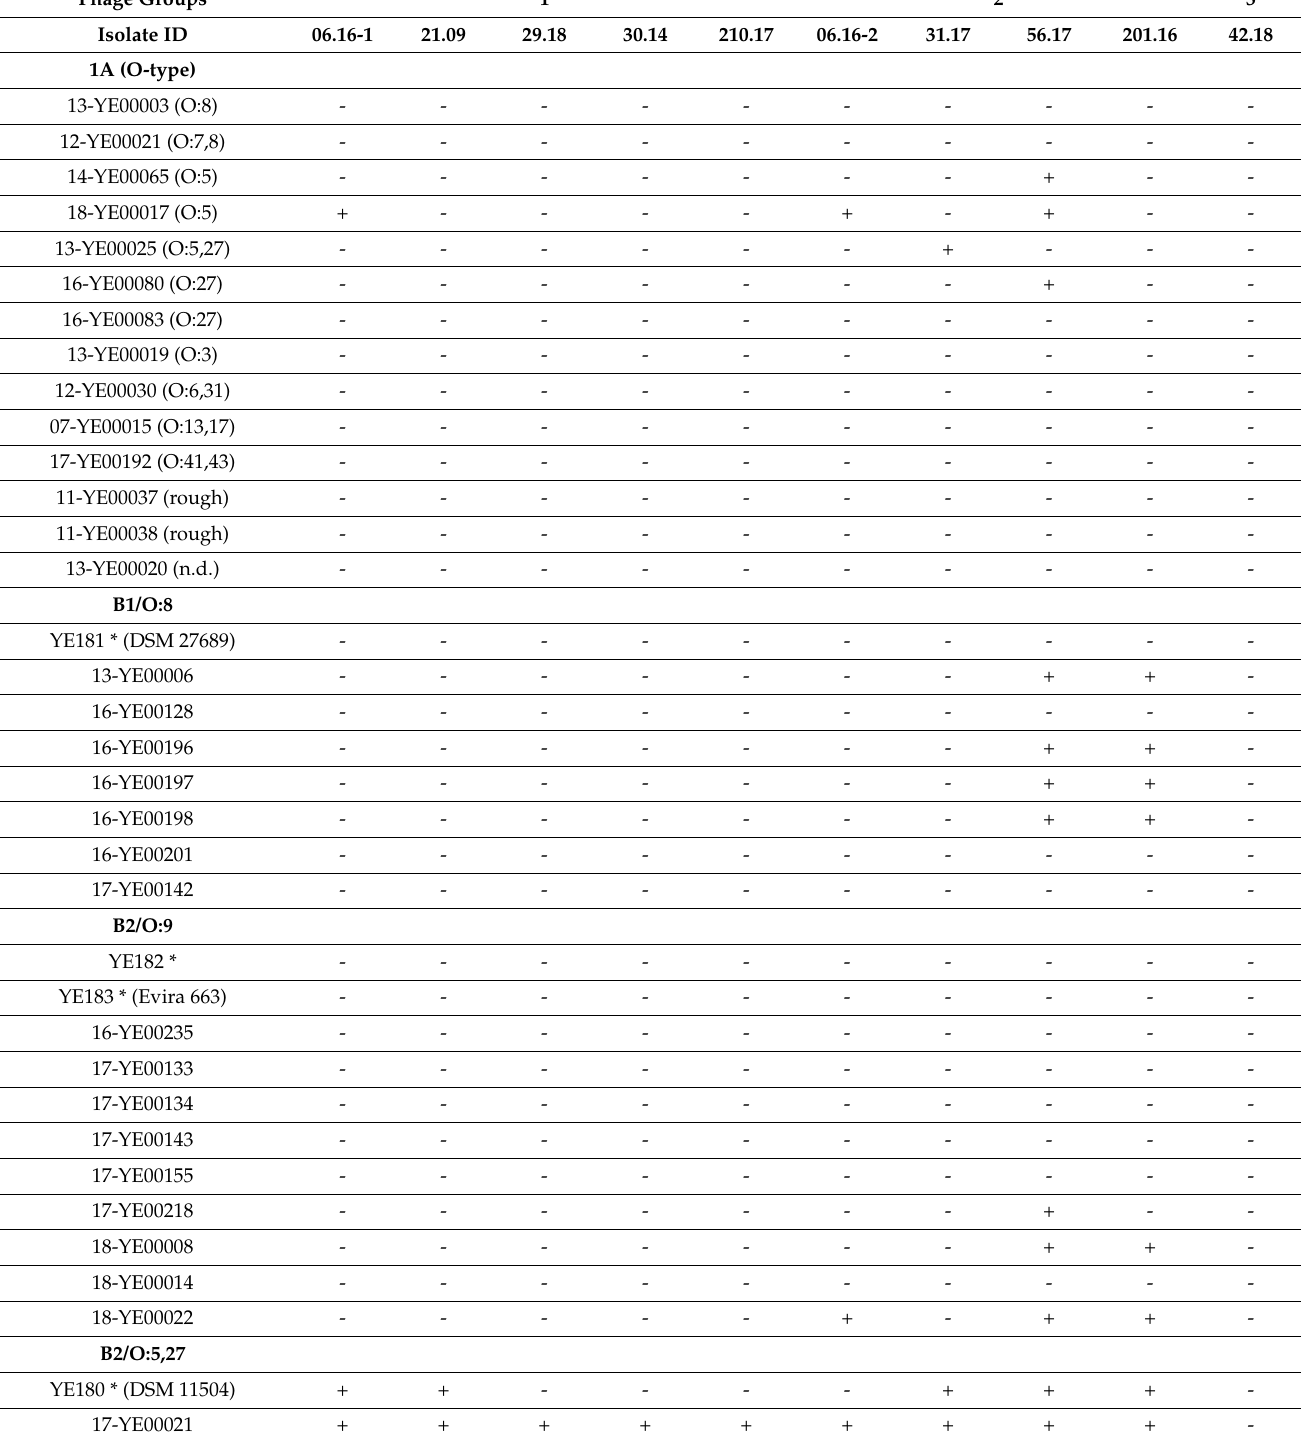
Table 3. Host range of the phages on Y. enterocolitica isolates at room temperature (RT). Phage